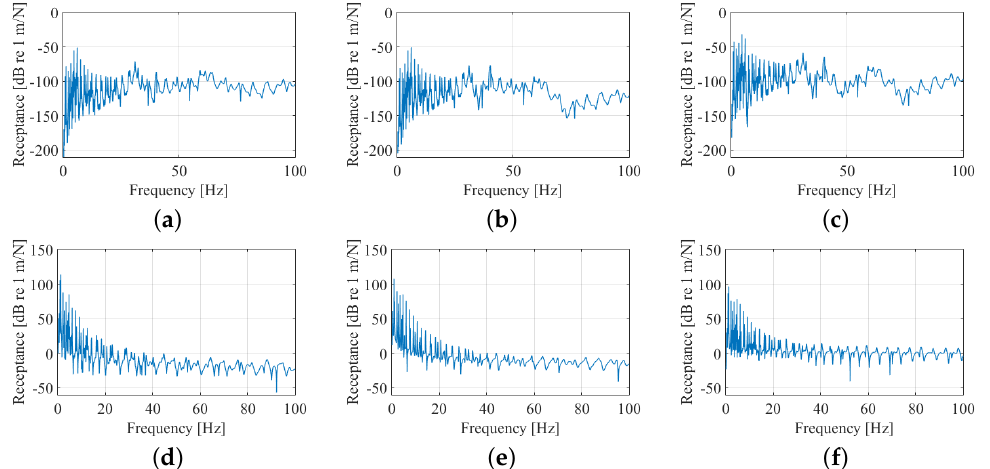
Figure 18. OTL receptances obtained by applying a distributed load over the cable and estimating at, ( a , b ) tower; ( c ) connection point, ( d ) cable 1 m from support; ( e ) cable middle length, and ( f ) cable end-span.